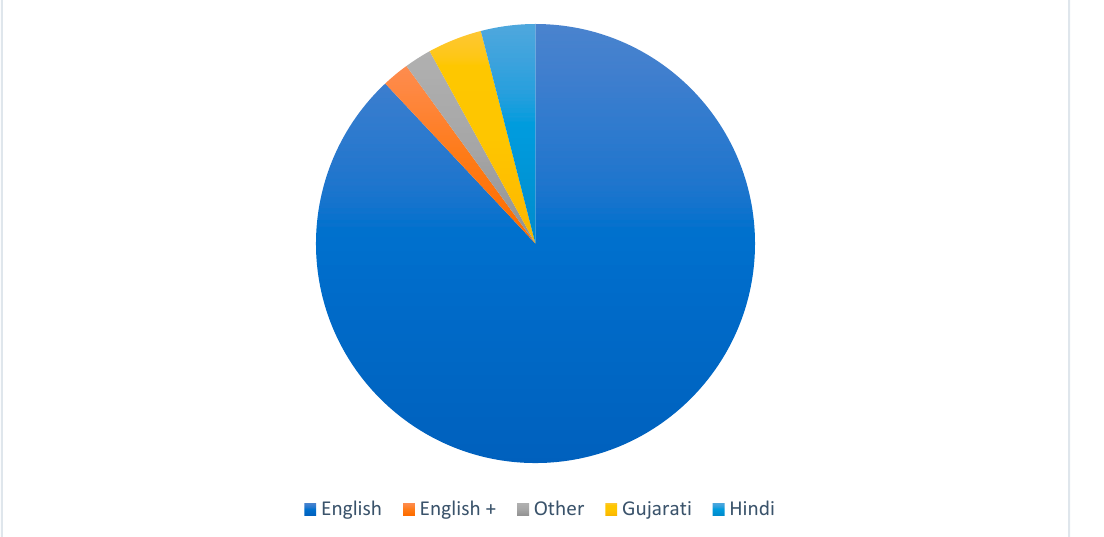
Figure 2. Language distribution for the 2017 website corpus.